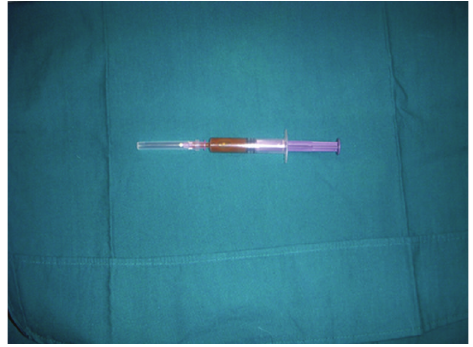
Figure 3: Aspirated material was a red colored, viscous